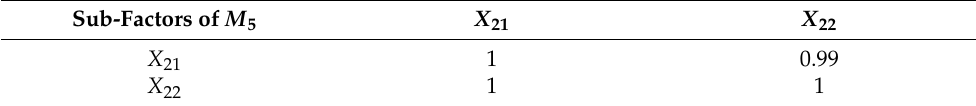
Table 12. Judgment matrix of the sub-factor layer to the upper factor M 5 .